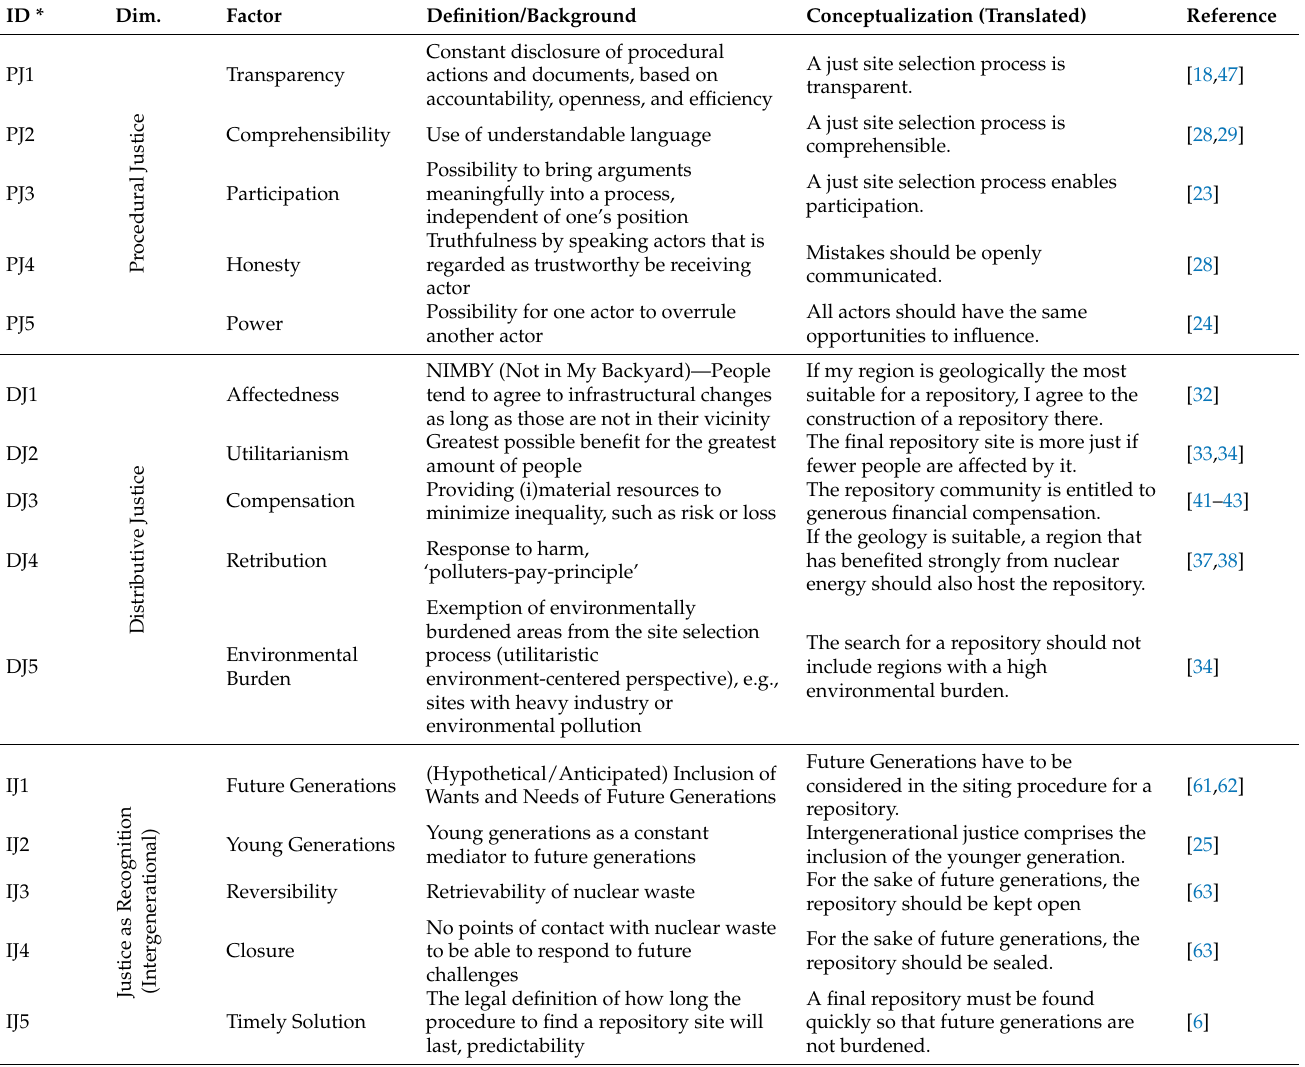
Table 1. Conceptual Framework for the Quantitative